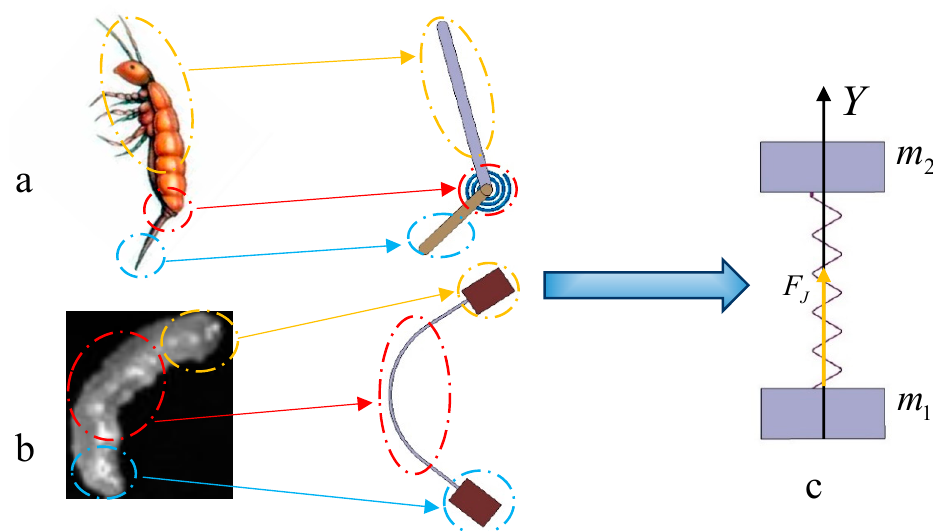
Figure 2. A bionic jumping mechanism for the jumping principle of jumping springtails ( a ) and gall midge larvae ( b ). A simplified model of a bionic mechanism ( c ).